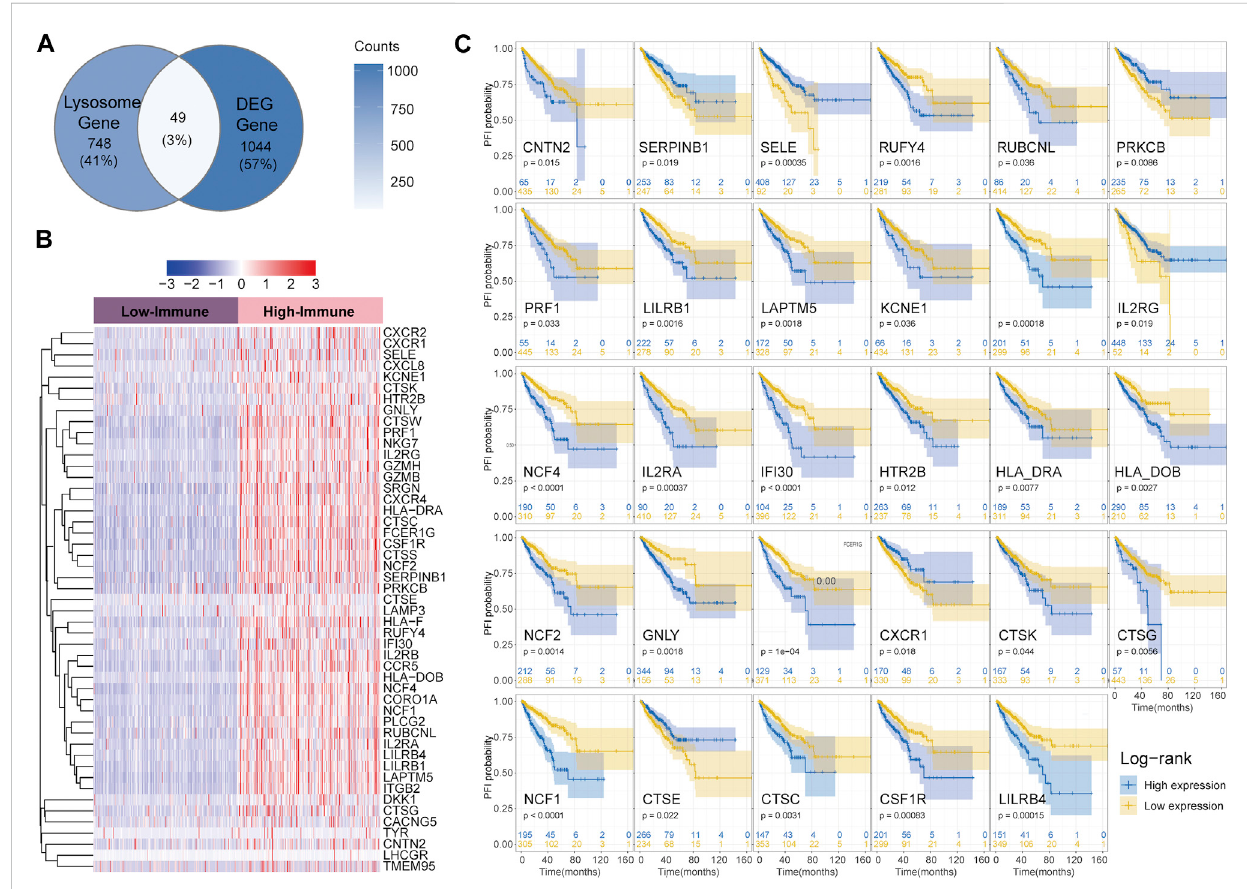
FIGURE 2 Identi fi cation of LIRGs between high and low-immune groups and its prognostic relevance (A) Venn diagram showing shared genes between IRGs and LRGs; (B) Heatmap of 49 LIRGs; (C) PFI analysis of 29 LIRGs associated with the prognosis.